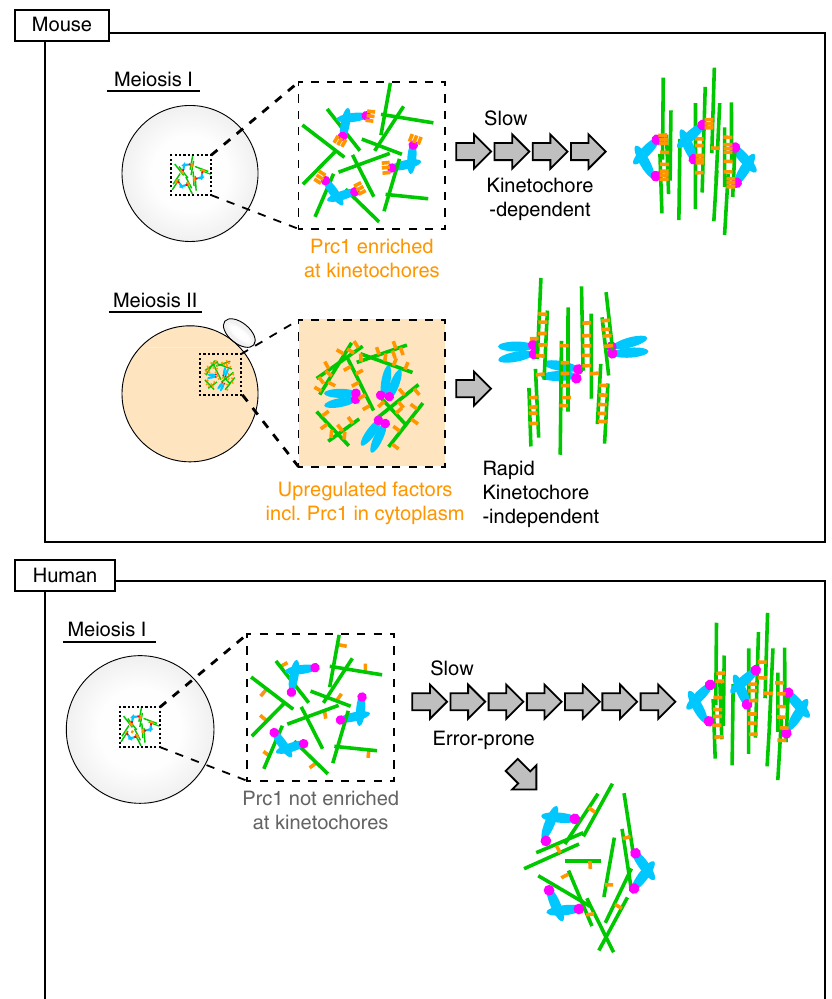
Fig. 8 Models for acentrosomal spindle bipolarization in mammalian oocytes. Different modes of spindle bipolarization. In mouse MI oocytes, Prc1 (orange) is highly enriched at kinetochores (magenta). The Prc1-rich kinetochore microenvironment is required for driving slow bipolarization of the spindle (green). This kinetochore-dependent spindle bipolarization is critical for MI to prevent chromosome segregation errors. In mouse MII oocytes, the cytoplasmic environment that contains upregulated factors including Prc1 provides global support to rapid, kinetochore-independent pathways for spindle bipolarization. In human MI oocytes, spindle bipolarization occurs without kinetochore-enriched Prc1, and is error